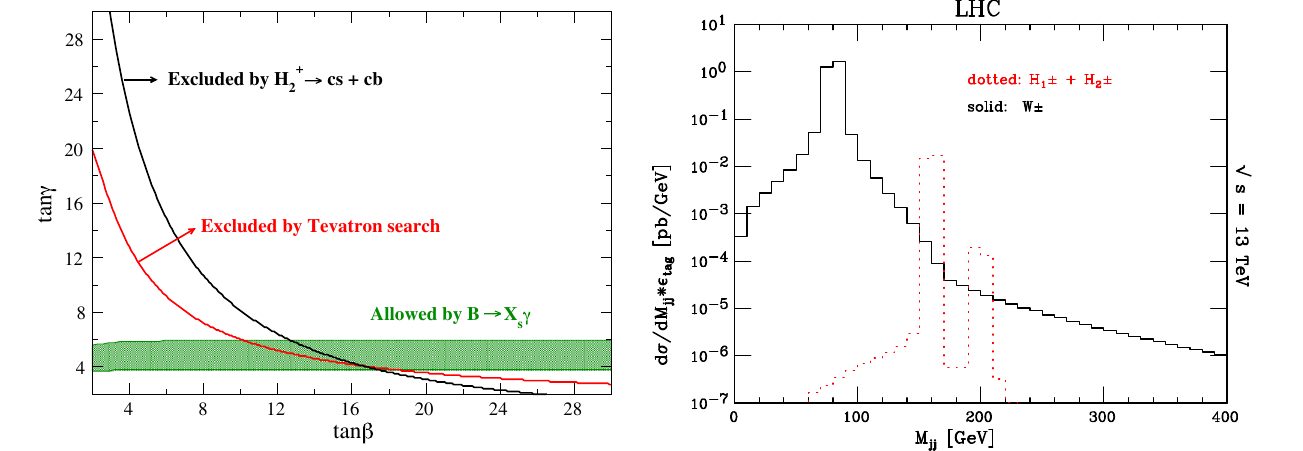
Fig. 26 Left Allowed parameter space for the 3HDM (Model Y) with = 83 GeV, M = 160 GeV and the mixing angle θ M H ± 1 H ± 2 Only the green shaded region is allowed by the B → X s γ constraint.